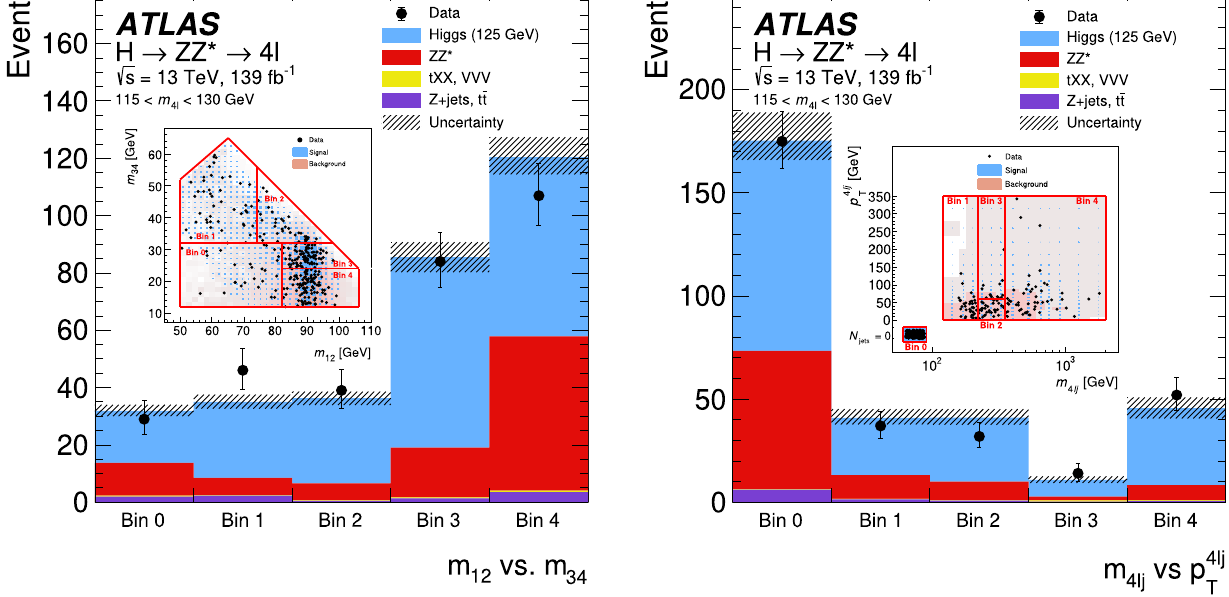
(cid:3) j vs. T √ s = 13 TeV.